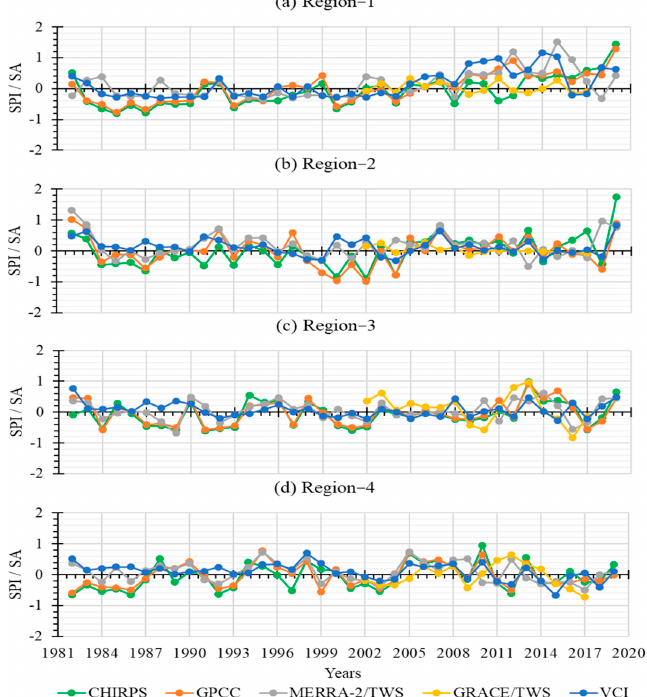
Figure 5. ( a – d ) Temporal assessment (SPI from CHIRPS, SPI from GPCC, TWSI from MERRA-2, SA from GRACE, and VCI from AVHRR) over the study region. Temporal valuation interpreted in conjunction with Table 2.